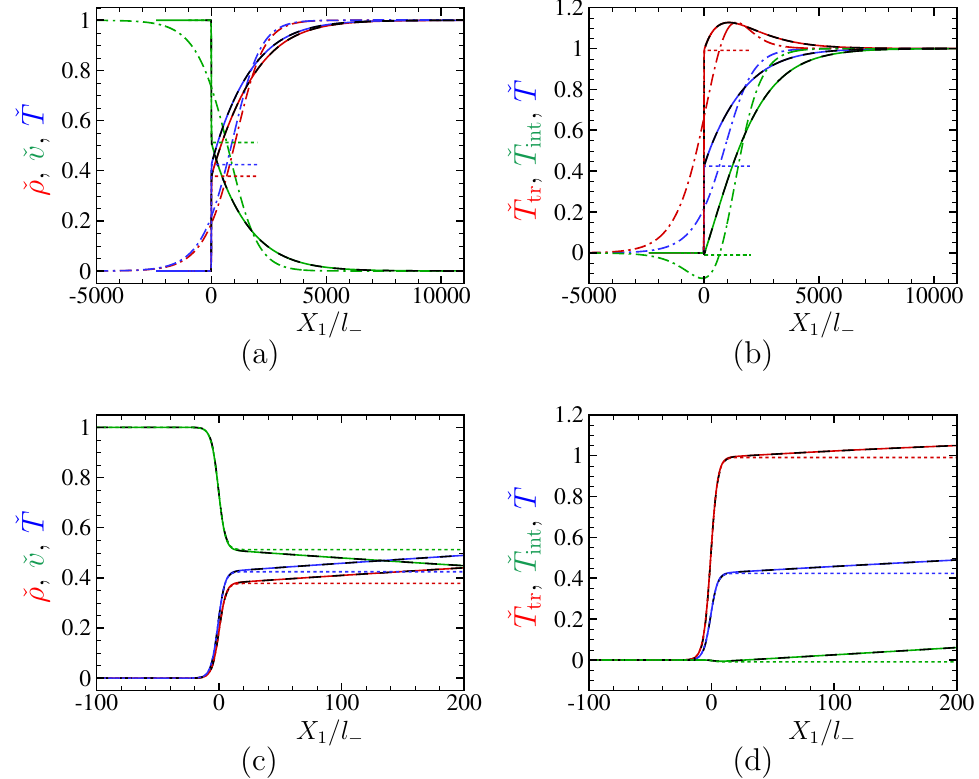
Figure 4. Profiles of ˇ ρ , ˇ v , ˇ T , ˇ T tr , and ˇ T int in the case of the pseudo-CO 2 gas at M − = 1.3 for µ b / µ = 1000. ( a , c ) ˇ ρ , ˇ v , and ˇ T ; ( b , d ) ˇ T tr , ˇ T int , and ˇ T . Panels ( c , d ) are, respectively, the magnified figures of panels ( a , b ) [except that the dot-dashed line is not included in panels ( c , d )]. The solid line indicates the result based on the two-temperature NS equations (18), the dotted line that for θ = 0 (or µ b / µ = ∞ ) based on the same equations, and the dot-dashed line that based on the ordinary NS equations (14). The red, green, and blue lines indicate, respectively, ˇ ρ , ˇ v , and ˇ T in panels ( a , c ) and ˇ T tr , ˇ T ˇ T in panels ( b , d ). The profiles based on the ES model (2) are shown by the black dashed line int , and for all quantities.